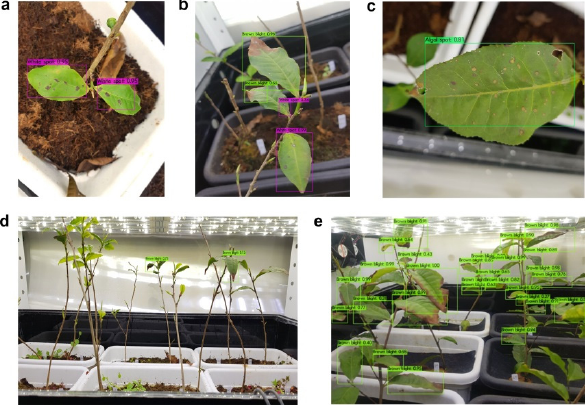
Figure 13. Detection results of leaf diseases: ( a ) white spot; ( b ) multiple infection (Taicha No. 18); ( c ) algal spot; ( d ) and ( e ) brown blight leaf disease. Green, light green, and purple coloured frames